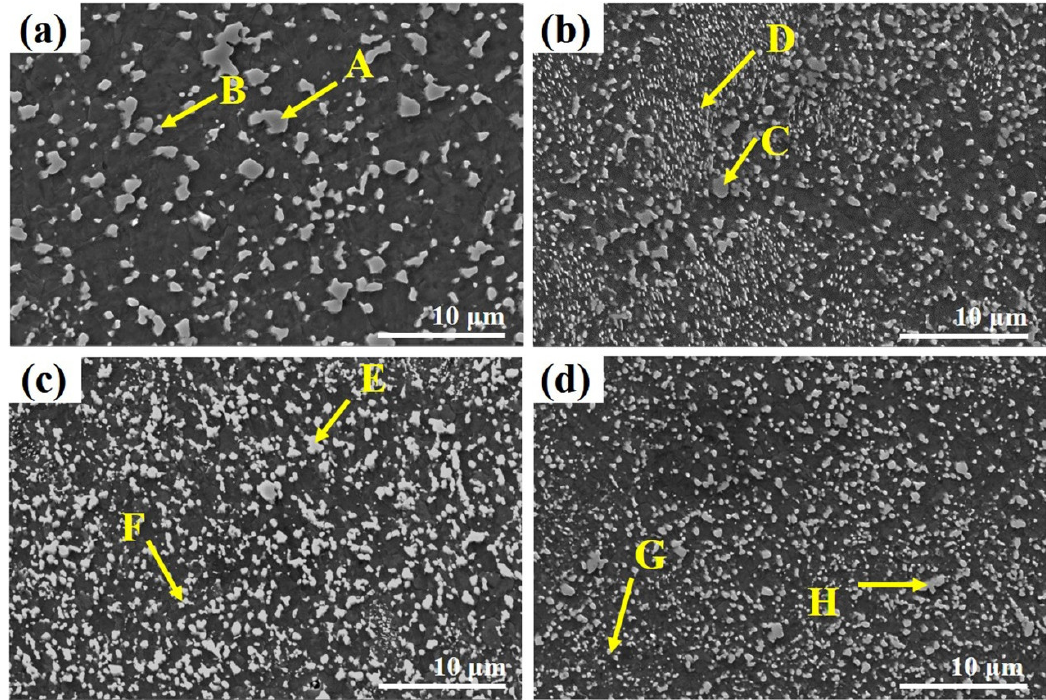
Figure 4. SEM images of AZ91 and AZ91-CaO alloy in extruded state: ( a ) AZ91-T4-EX, ( b ) AZ91-T6- Table 2. EDS result of AZ91-EX and AZ91-CaO-EX in Figure 4.